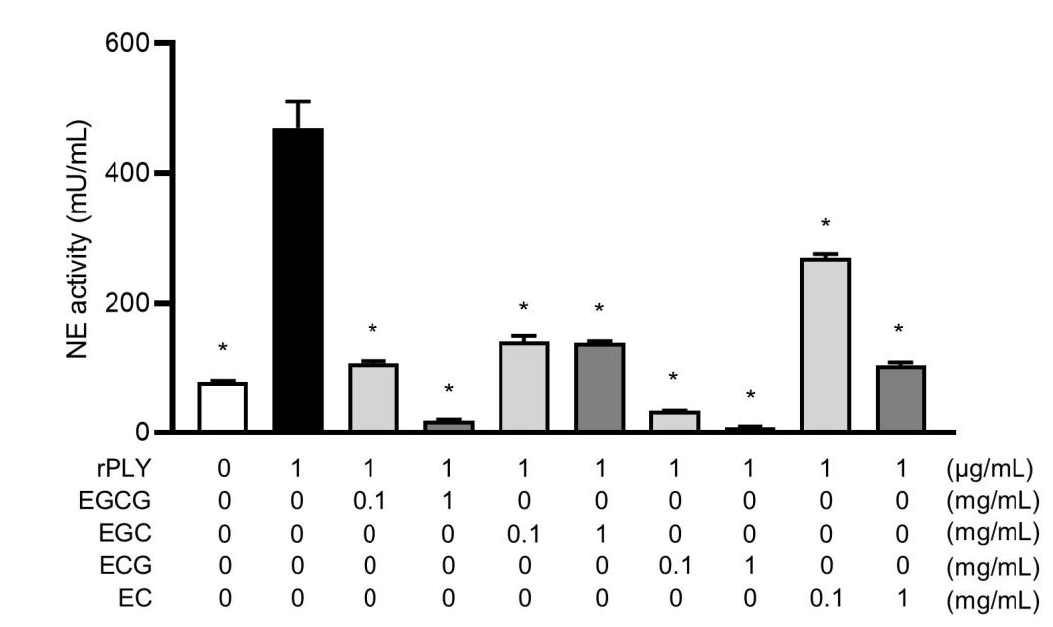
Figure 7. Catechins decreased recombinant PLY-stimulated NE release from neutrophils. Human neutrophils (5 × 10 5 cells/200 µ L) were exposed to rPLY (1 µ g/mL) at 37 ◦ C for 1 h in the presence or absence of EGCG, EGC, ECG, and EC (0.1 and 1 mg/mL). NE activity in the culture supernatant was evaluated using an elastase activity assay kit. Data are presented as the mean ± SD ( n = 3 per group) and were evaluated using one-way analysis of Dunnett’s multiple-comparisons test. * p < 0.05 versus the PLY only-treated